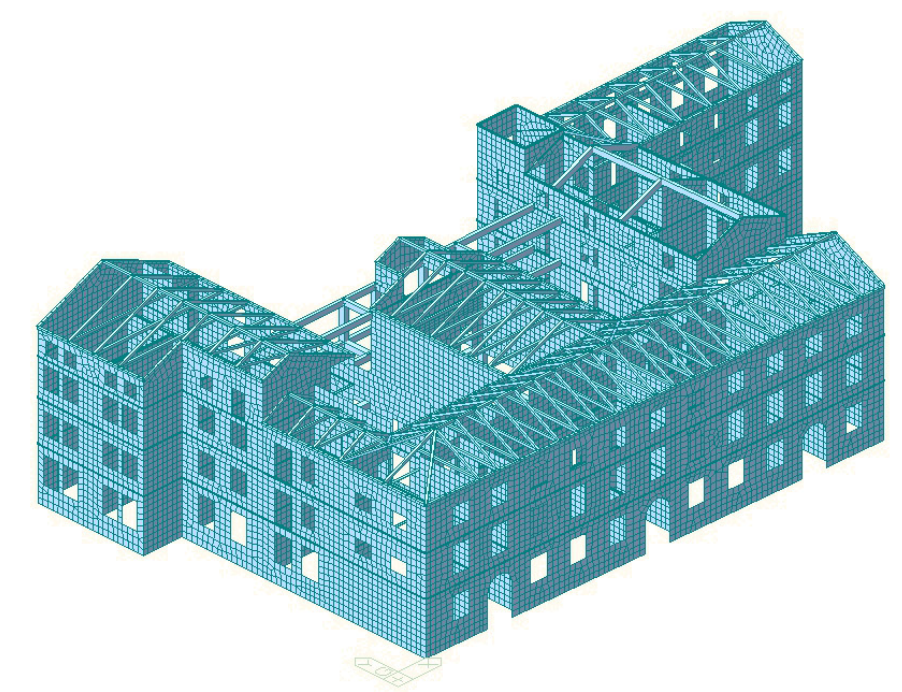
Figure 11. Finite element model used for the static, linear elastic analysis of the whole building complex.